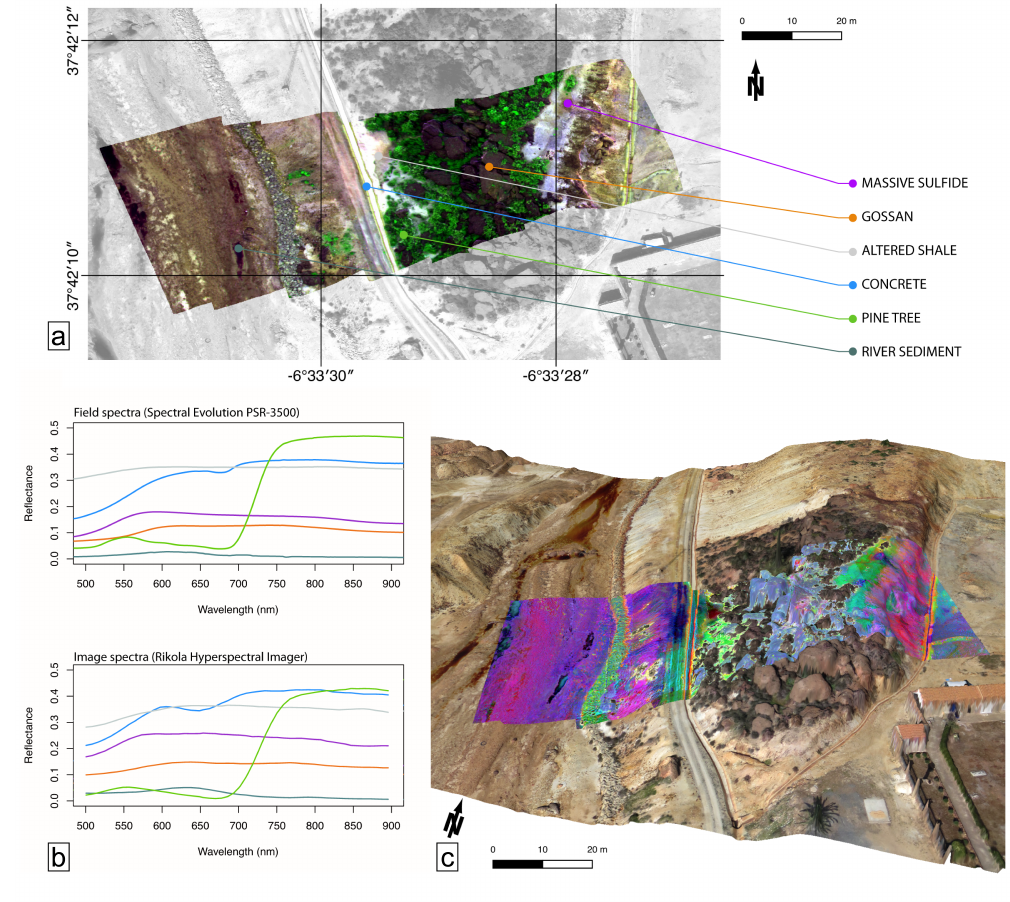
Figure 6. ( a ) Corrected and geolocated hyperspectral mosaic with the location of spectral validation sampling points. Displayed bands are: red: Band 19 (651nm); green: Band 45 (856nm); blue: Band 7 (552nm). ( b ) Comparison of field and image spectra taken from the points of interest displayed in ( a ). ( c ) Vegetation masked Principal Components 2, 3 and 5, draped on a 3D orthophoto model of the test site (view from